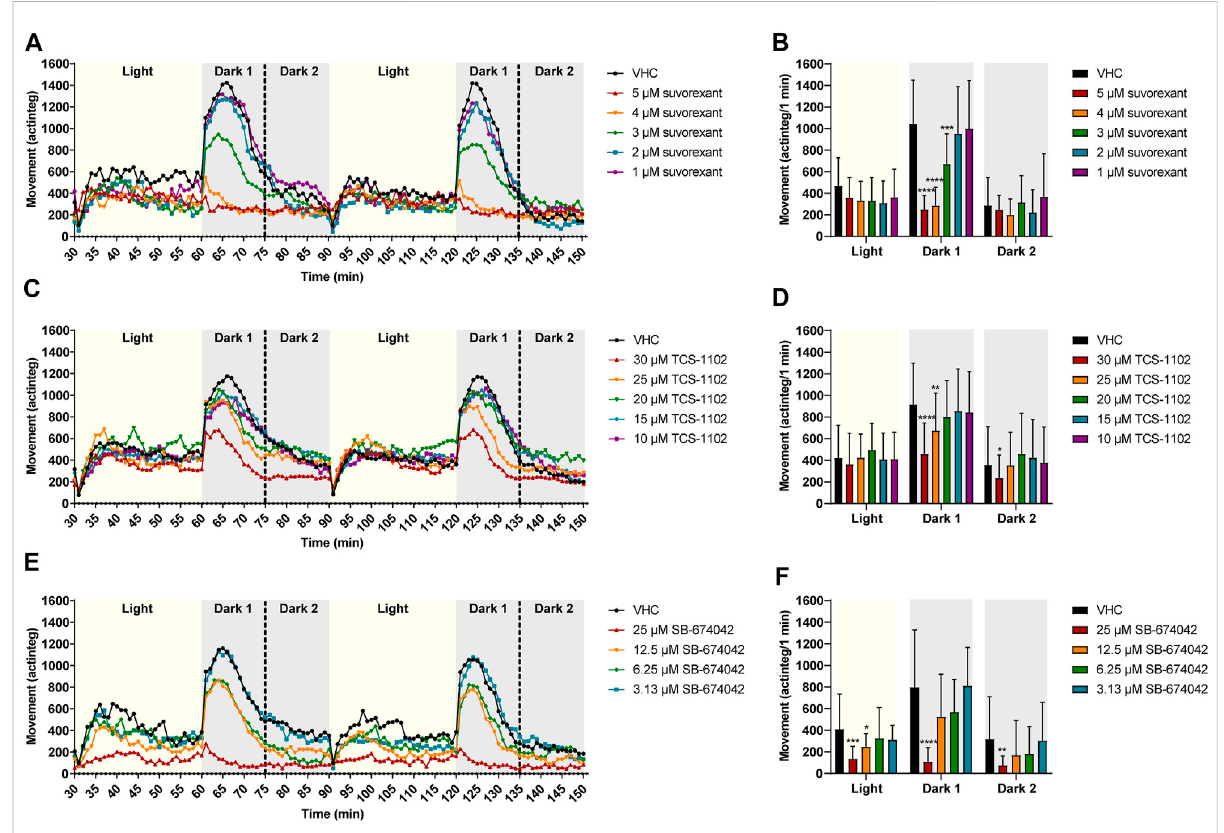
FIGURE 6 Behavioral analysis of 6 dpf zebra fi sh larvae treated with orexin receptor antagonists in the dark-light assay. Locomotor pro fi les of animals are expressedasmeanactinteg unitsper1 mintreatedwithsuvorexant (A) ,TCS-1102 (C) andSB-674042 (E) areplottedasfunctionoftime.Forthesake ofclarity,standarddeviationsarenotshown. Differentphasesareshown,i.e.,30 minlightphase(Light),the fi rst15 minofthedarkphase(Dark1)and the last 15 min of the dark phase (Dark 2). Total locomotor activity was averaged (±SD) per respective light or dark phase (B – F) . For each compound, data were pooled from three or nine independent experiments with 9 – 20 replicate wells per test condition ( n = 29 – 40, except for VHC (C,D) n = 110) and 30 µM TCS-1102 ( n = 50)). Statistical analysis: two-way ANOVA with Dunnett ’ s multiple comparison test. Signi fi cance levels: * p